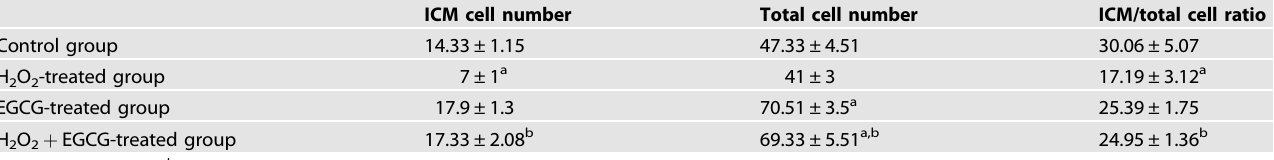
Table 1. Comparison of ICM cell number and ICM/total cell ratio in IVF embryos with different